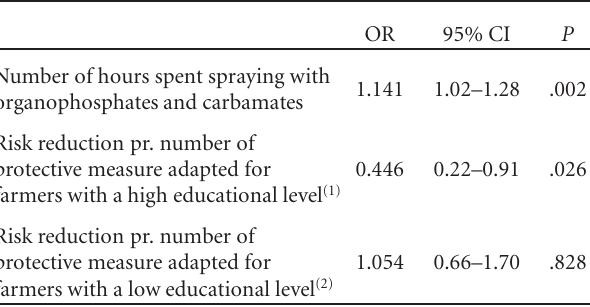
Table 5: Logistic regression model for the risk of acute pesticide poisoning among 87 farmers in Boeung Cheung Ek Lake, Phnom Penh,